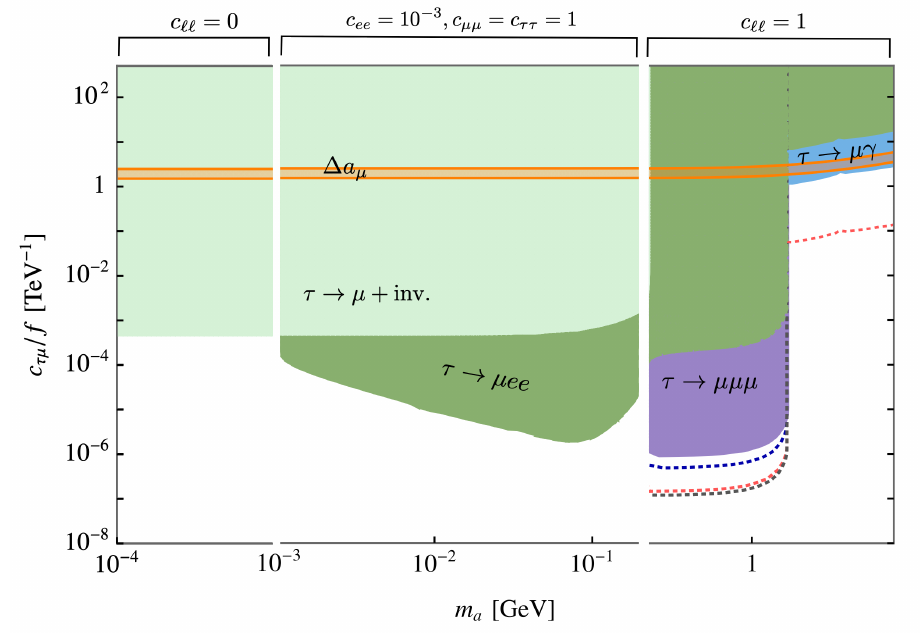
Figure 45 . Bounds on ALP mediated flavor off-diagonal transitions between taus and muons with p c τµ ≡ | [ k E ] 32 | 2 + | [ k e ] 32 | 2 , assuming universal ALP couplings to leptons as indicated above the plot for the different ALP mass